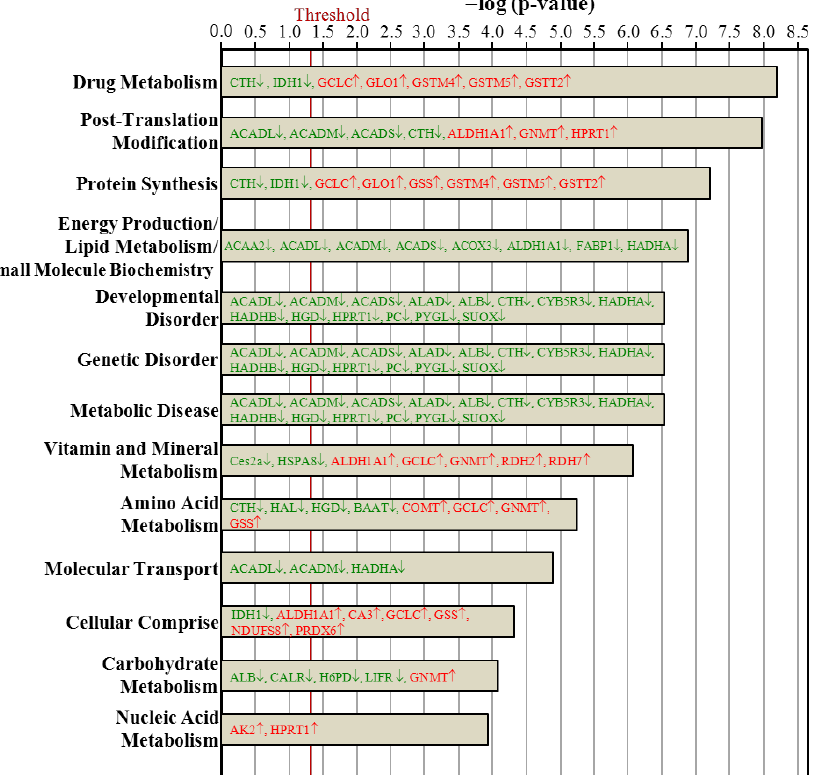
Figure 6. Comparison of biologic function proteins between the Ovx and Sham groups. Only the 15 most different biologic functions are shown, ranked by the significance in the Ovx group. The vertical line indicates a threshold of p < 0.05.